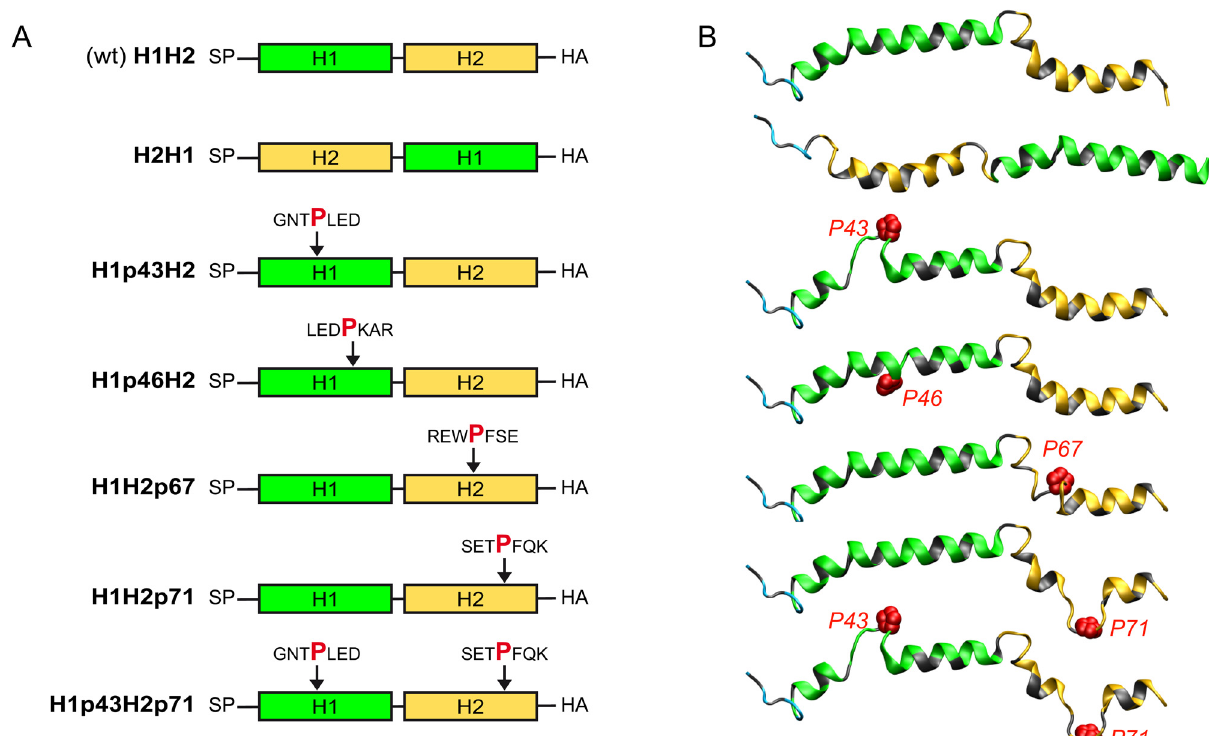
Fig 5. Schematic model and ribbon representation of wild type ApoC1 and mutant proteins. A: Schematic depiction and B: predicted 3D structural models of wild-type ApoC1 (H1H2) and six mutants including swapped helices (H2H1), and proline insertions after given amino acid positions to disrupt formation of the first helix (H1p43H2 and H1p46H2) or the second helix (H1H2p67 and H1H2p71), or both helices (H1p43H2p71). Hydrophobic residues are colored grey while polar residues are colored cyan, green and yellow in the N-terminus segment, helix 1 and helix 2, respectively. The side-chain atoms of inserted proline residues are represented as red spheres of the corresponding van der Waals radius. The reader is looking at the polar sides of helices 1 and 2 (green and yellow, respectively) while their hydrophobic sides (colored gray) are on the opposite side, interacting with the membrane surface (represented by the background). SP = signal peptide